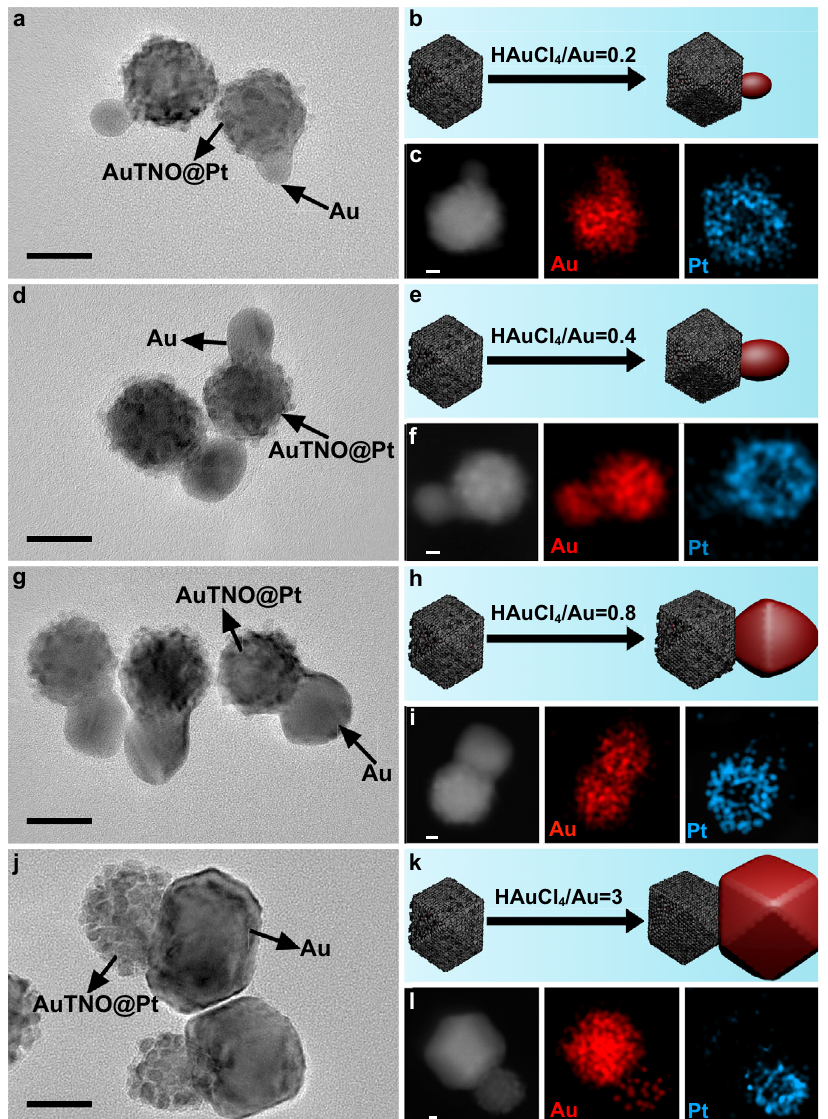
Fig. 8 Dimension control of nanocrystals. TEM images, schematic illustrations, and elemental maps of products prepared through tuning the molar ratio of HAuCl 4 and Au when using AuTNO@Pt nanocrystals as seeds: a , b , c 0.2; d , e , f 0.4; g , h , i 0.8; j , k , l 3. Scale bars in a , d , g , j are 20 nm. Scale bars in c , f , i , l are 5 nm. In all schematics, the red and gray colors represent Au and Pt,